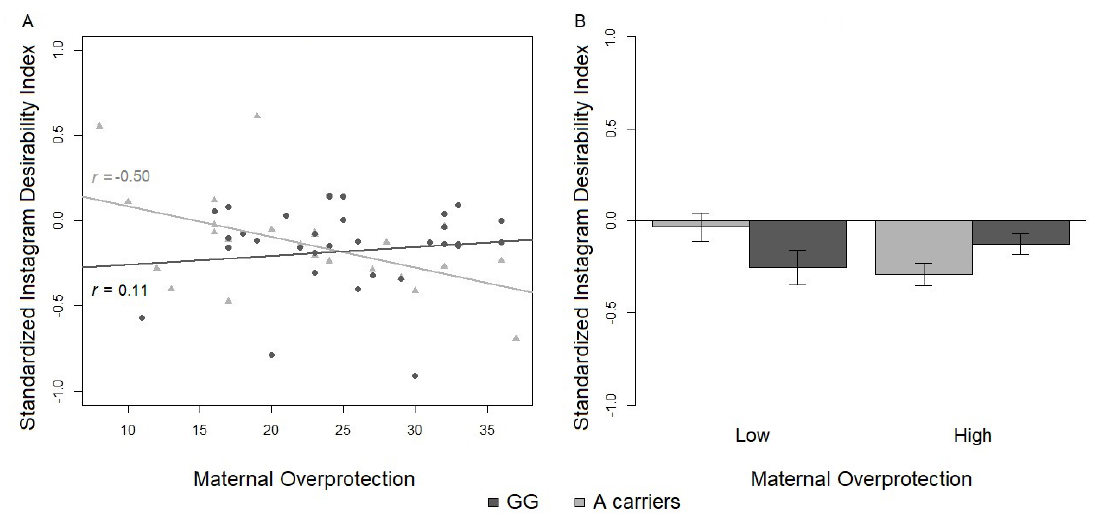
Figure 3. ( A ) Effect of the interaction between maternal overprotection and genotype on the standardized Instagram Social Desirability Index. Correlations between the Social Desirability Index and the reported maternal overprotection. Black circles = G/G homozygotes; grey triangles = A-carriers. Lines constitute the linear models for G/G homozygotes (black) and A-carriers (grey). r -values refer to Pearson’s r correlations. ( B ) Comparison between the Social Desirability Index in G/G homozygotes (black) and A-carriers (grey) divided into high and low maternal